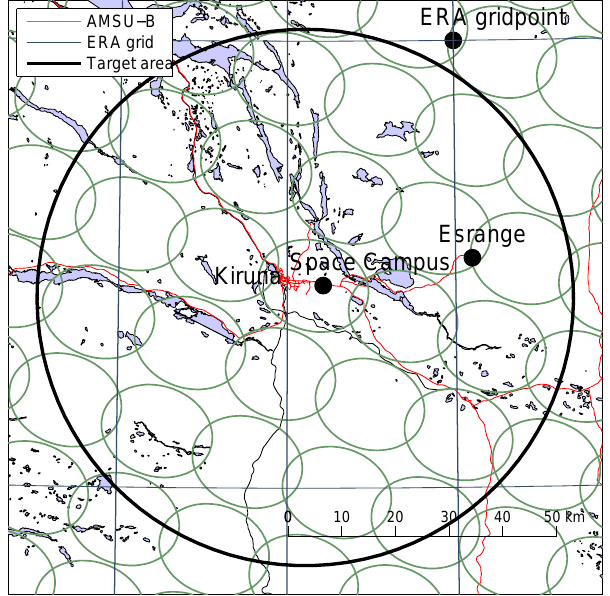
Fig. 1. A map of the intercomparison area. The map indicates the location of the measurement sites and the ERA-grid. The two mea- surement sites at Esrange are shown by a single dot. The AMSU-B footprints illustrate a single overpass; the complete set of measure- ments used in this study do not lie on a grid, but are spread though the target area. The background map data are© OpenStreetMap contributors,